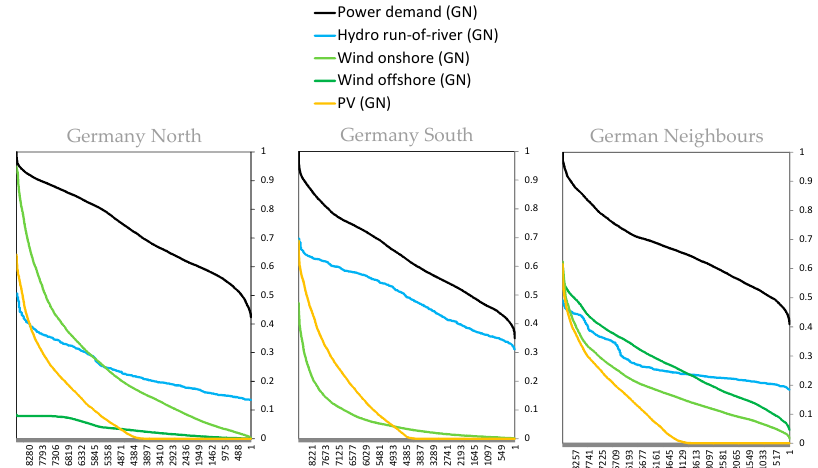
Figure A3. Duration curves of power demand and feed-in series of the four fluctuating RE power plant technologies. Hydro run-of-river profiles are given in 24-hour resolution. Fluctuating RE profiles are given based on the respective rated capacity. Power demand was normalized with the respective peak load in the model node. Source: Own composition based on [24,3331,4240] .